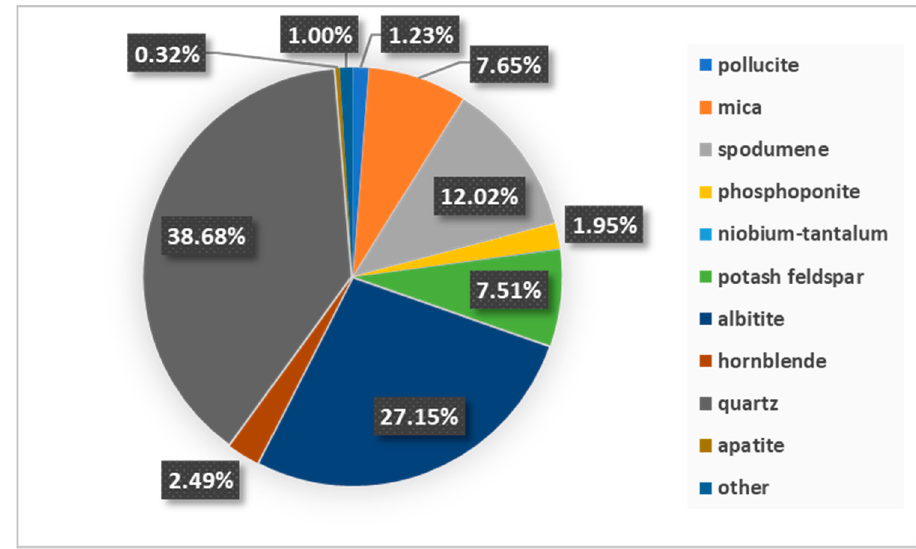
Figure 2. Results determining the mineral composition and content.